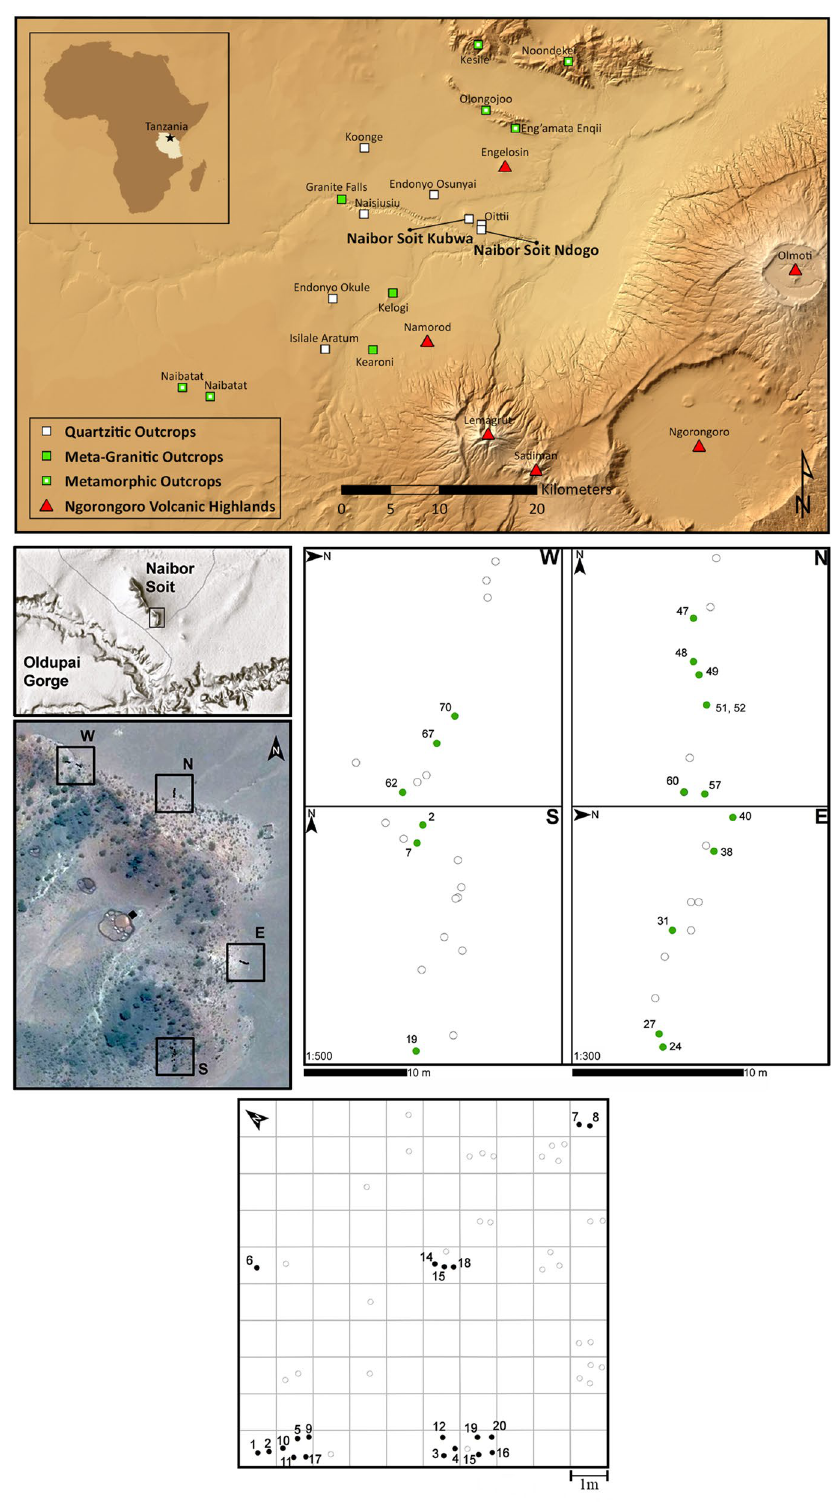
Figure 1. Location map of study area and sampling localities. Top panel: main geological outcrops in the region and location of Naibor Soit Kubwa. Center-left: sampling transects, with cardinal orientation (N, S, E, W), for surface rock collection. The larger image shows the position of the excavated sampling grid in the center (solid black square). Center-right: detailed provenance map within their respective sampling transects (N, S, E, W). Bottom panel: excavation grid showing location of buried